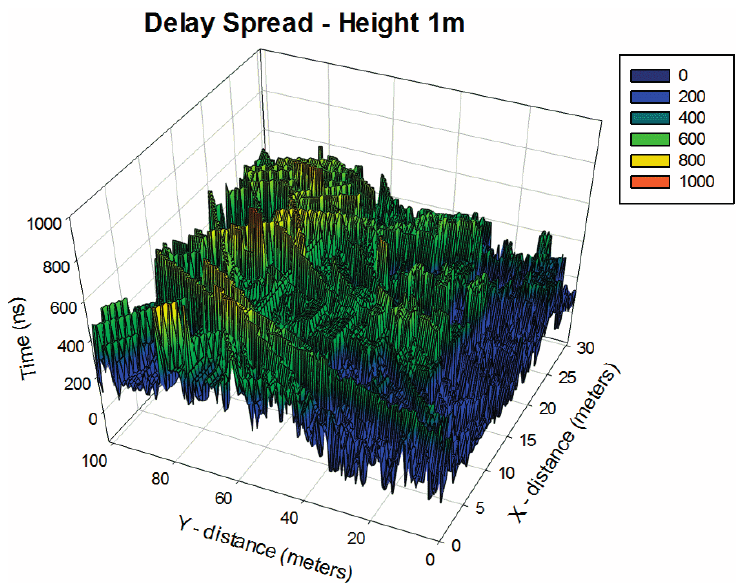
Figure 8. Delay Spread estimation within the considered scenario at 1 m